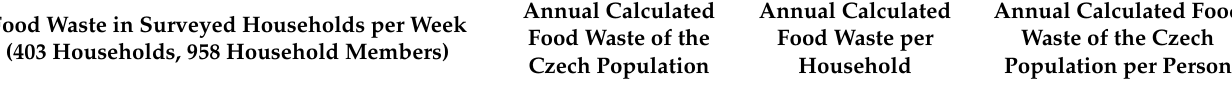
Table 2. Food waste during one-week measurement and estimation of annual values.